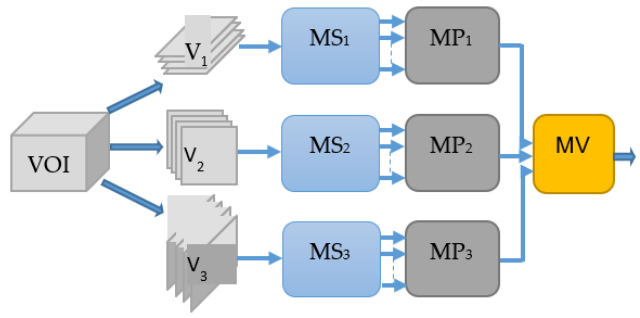
Figure 3. Block diagram of the proposed model.